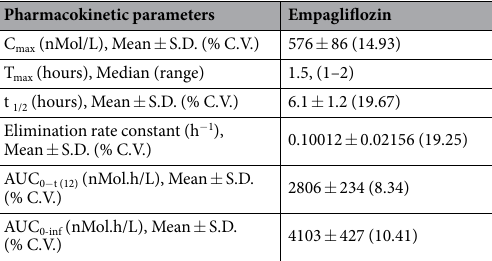
Table 1. Pharmacokinetic parameters of empagliflozin (EG) following oral administration of one JARDIANCE tablet nominally containing 25 mg of EG. Abbreviations: AUC = area under the curve; % C.V. = percent coefficient of variation; S.D. = standard deviation.